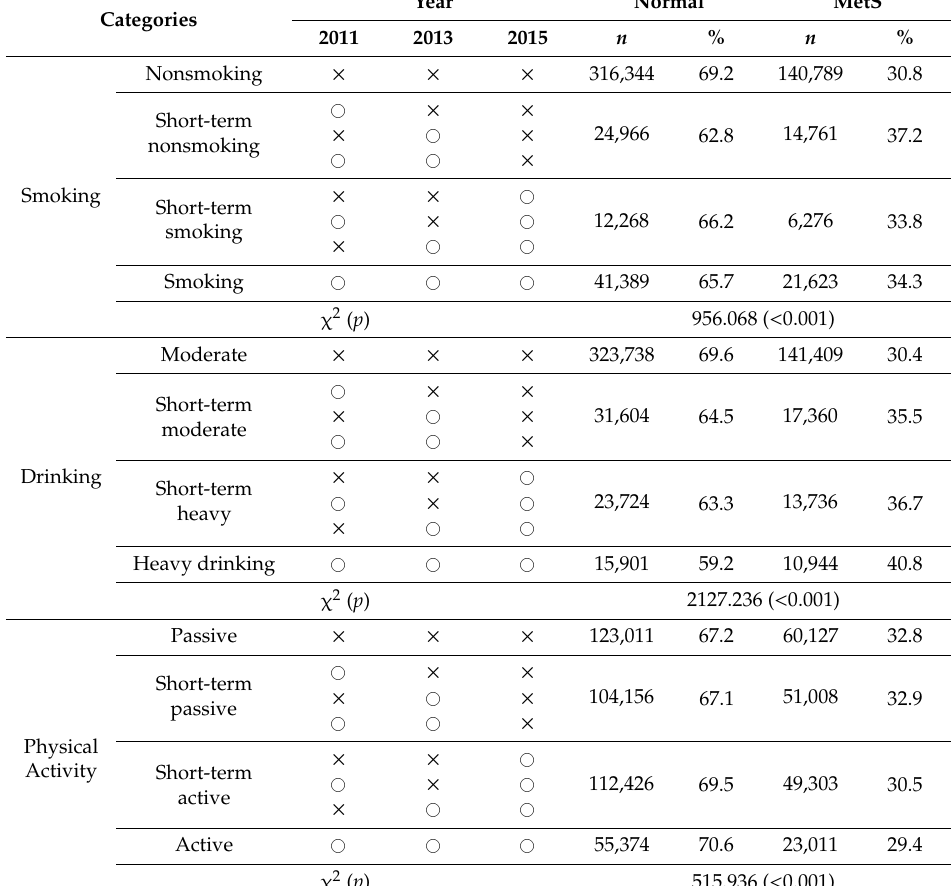
Table 4. Health-related behavior change and metabolic syndrome